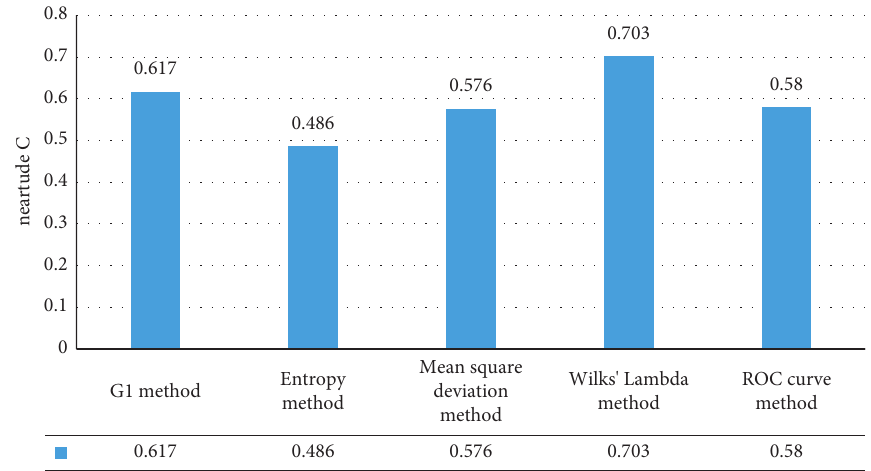
Figure 2: The neartude of five types of weighting methods. Table 8: Optimal weighting result of Wilks’ Lambda